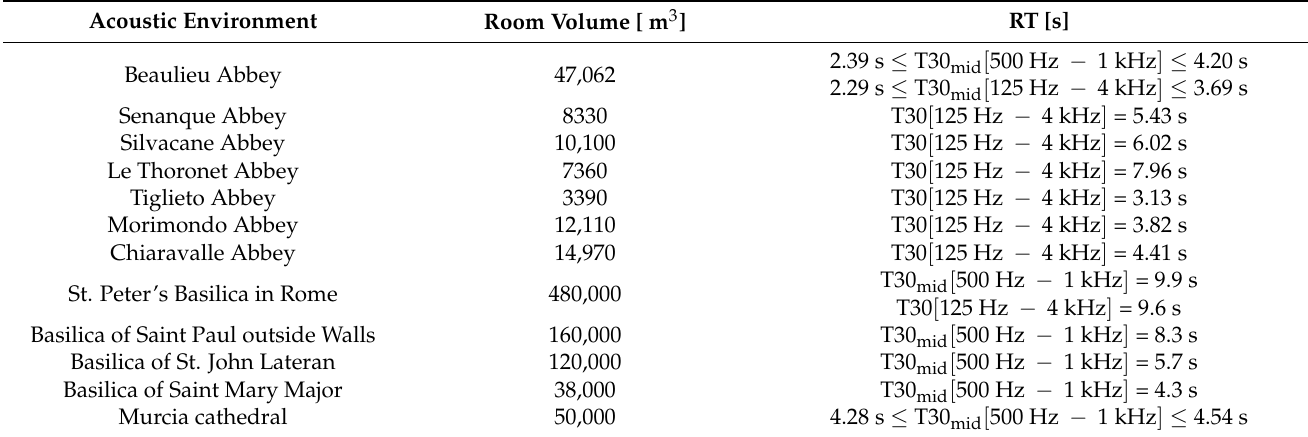
Table 7. Spatially and frequency averaged RT values